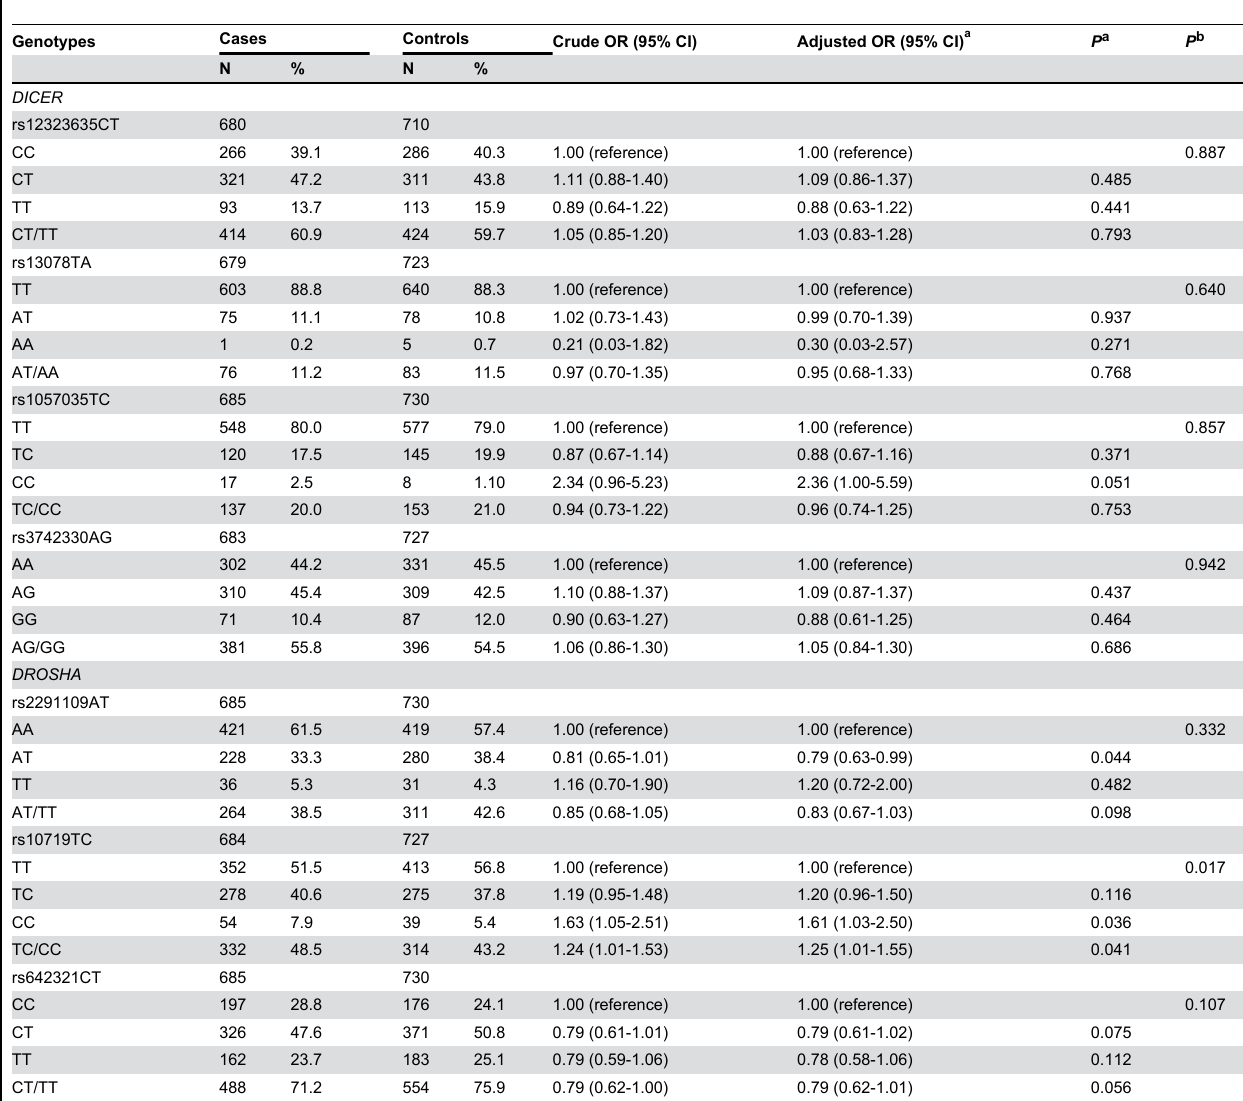
Table 3. Genotype frequencies of the DICER and DROSHA SNPs among bladder cancer cases and controls and their association with bladder cancer